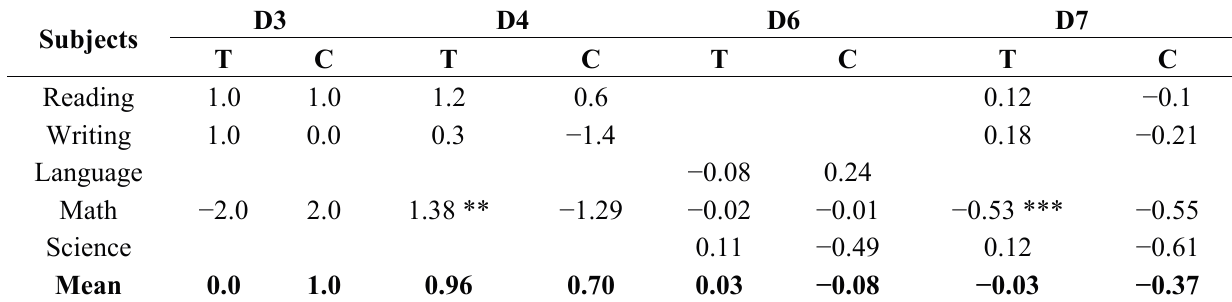
Table 5. Changes in Subject Achievement by Treatment (T) and Control (C)